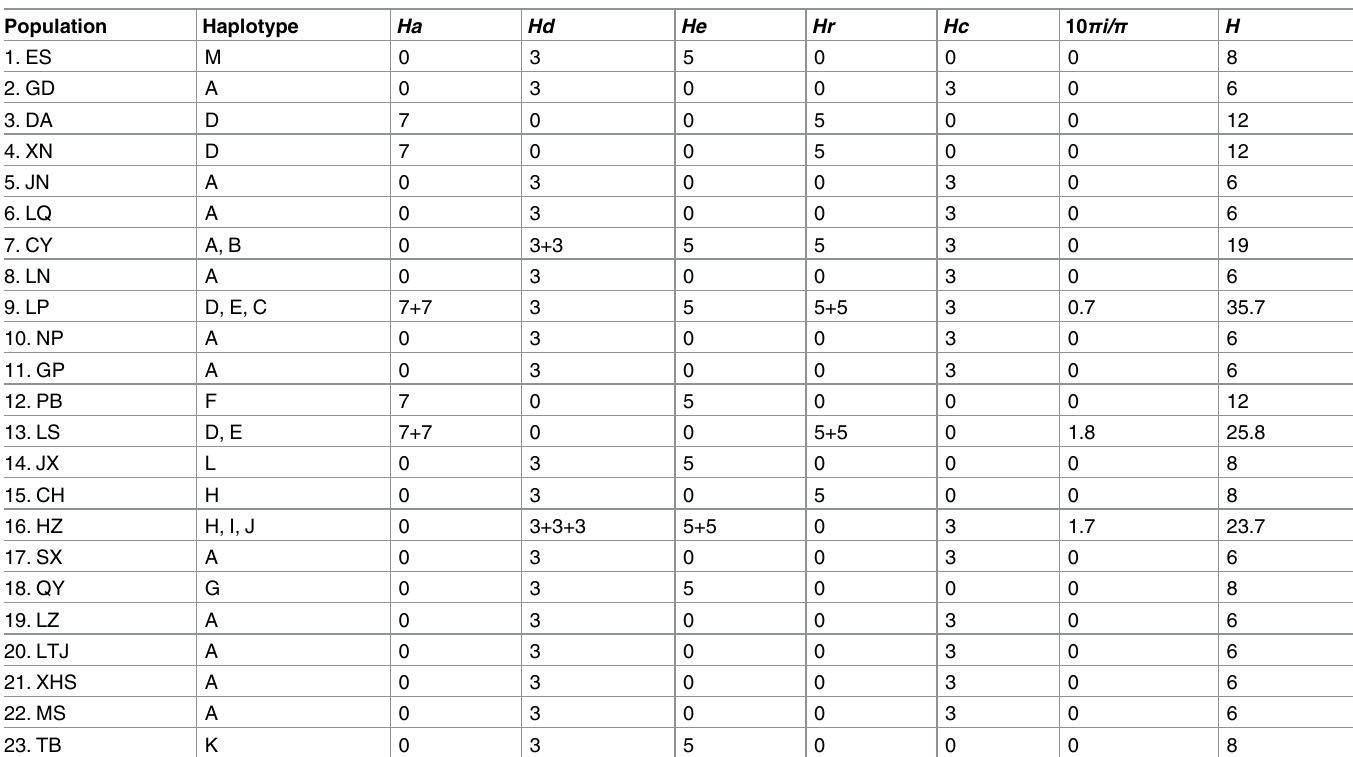
Table 5. H values for Bretschneidera sinensis